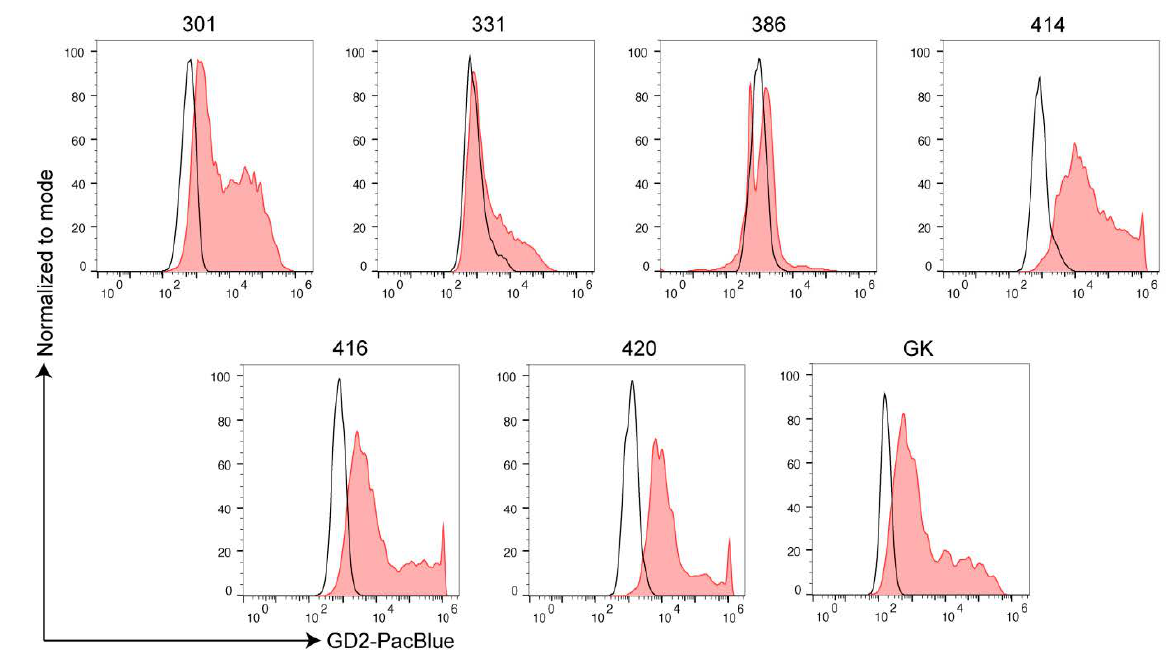
Figure 5. OS generally express low amount of GD2. Primary tumor cells of the indicated samples were analyzed by flow cytometry with an anti-GD2 antibody. Unstained samples were used as negative controls (black